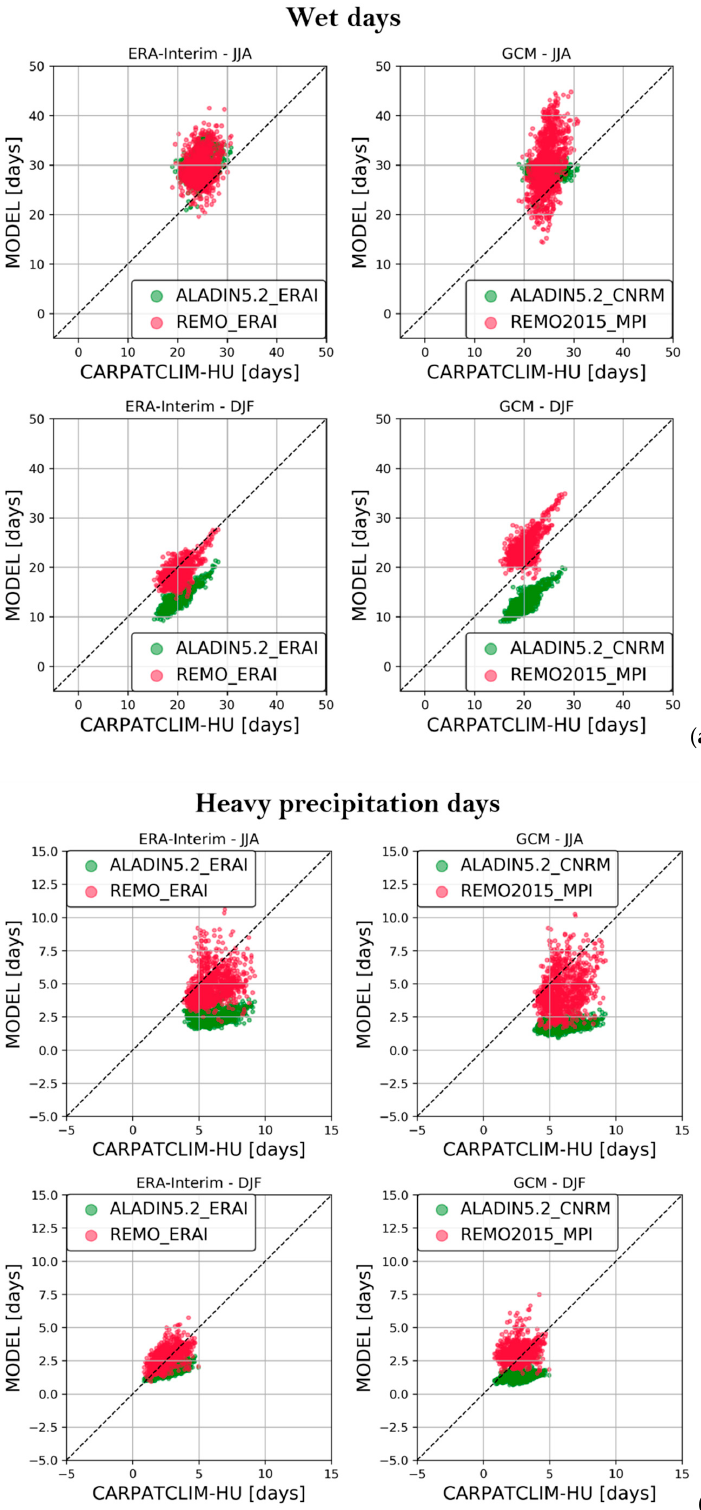
Figure 8. Mean values of ( a ) wet days and ( b ) heavy precipitation days in summer and winter for 1981–2000 based on the CarpatClim-HU observation dataset ( x -axis) and the RCM simulations ( y -axis). Each dot represents the value of one grid point over